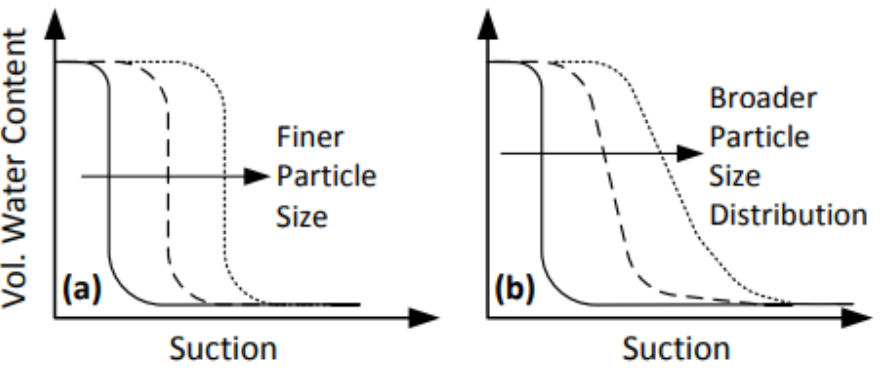
Figure 1: Conceptual diagram showing the effect of (a) median particle size of uniform sand and (b) width of particle size distribution, on the shape of the soil-water characteristic curve (SWCC) of sand (Craig H. Benson et al.